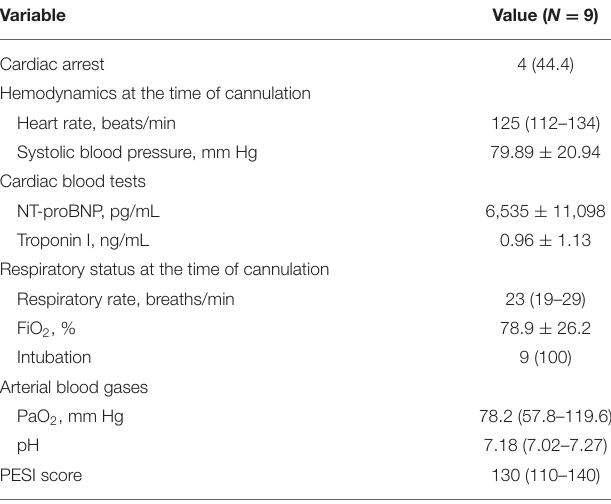
TABLE 2 | Clinical and laboratory characteristics of patients before VA-ECMO